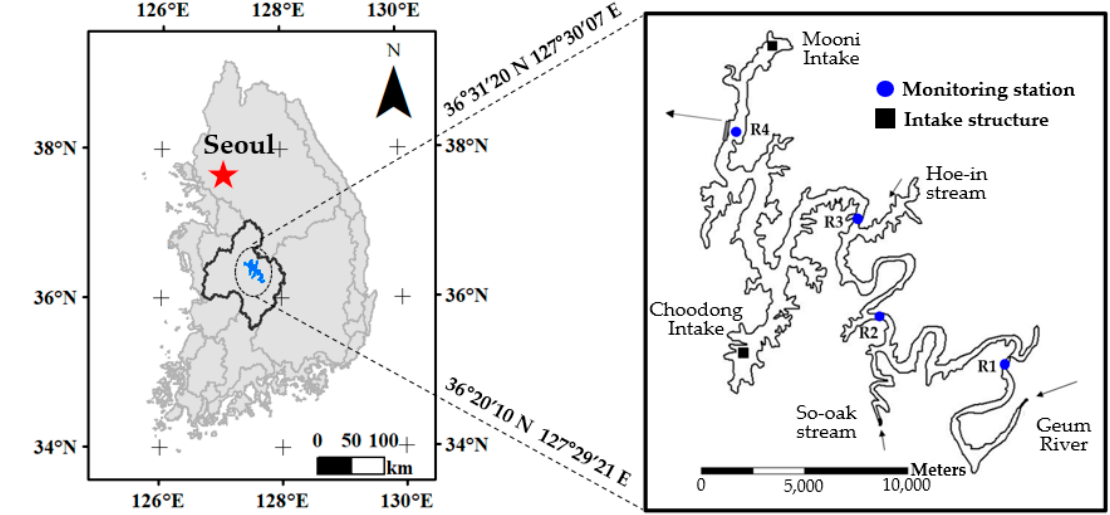
Figure 1. Location of the study site and monitoring station.